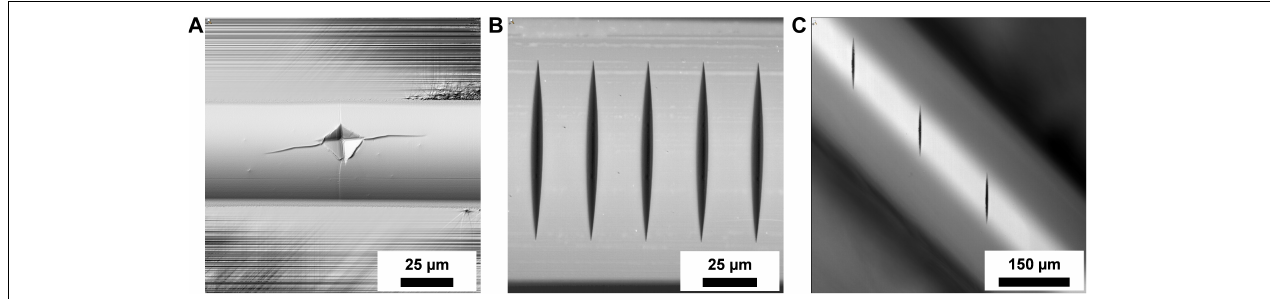
FIGURE 3 | (A) Surface visualization of a residual Vickers hardness imprint created at a normal load of 2.94 N on a 125 µ m silica glass fiber. The asymmetric shape results from intentional misalignment of the Vickers tip relative to the fiber apex by about 7 µ m. (B–C) Optical micrographs of residual imprints on a 440 µ m silica glass fiber produced with a wedge-shaped tip with an opening angle of 90 ◦ and an effective length of 215 µ m in (B) 90 ◦ and (C) 45 ◦ orientation relative to the fiber axis. The maximum loads were 3.62 N and 4.06 N, respectively.